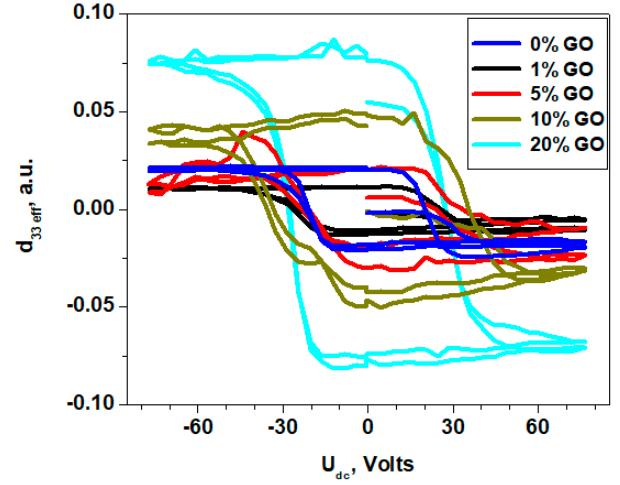
Figure 6. Piezoresponse hysteresis loops of P(VDF-TrFE)-graphene oxide fibers with different concentration of GO. U ac = 7.5 V, 40 kHz.